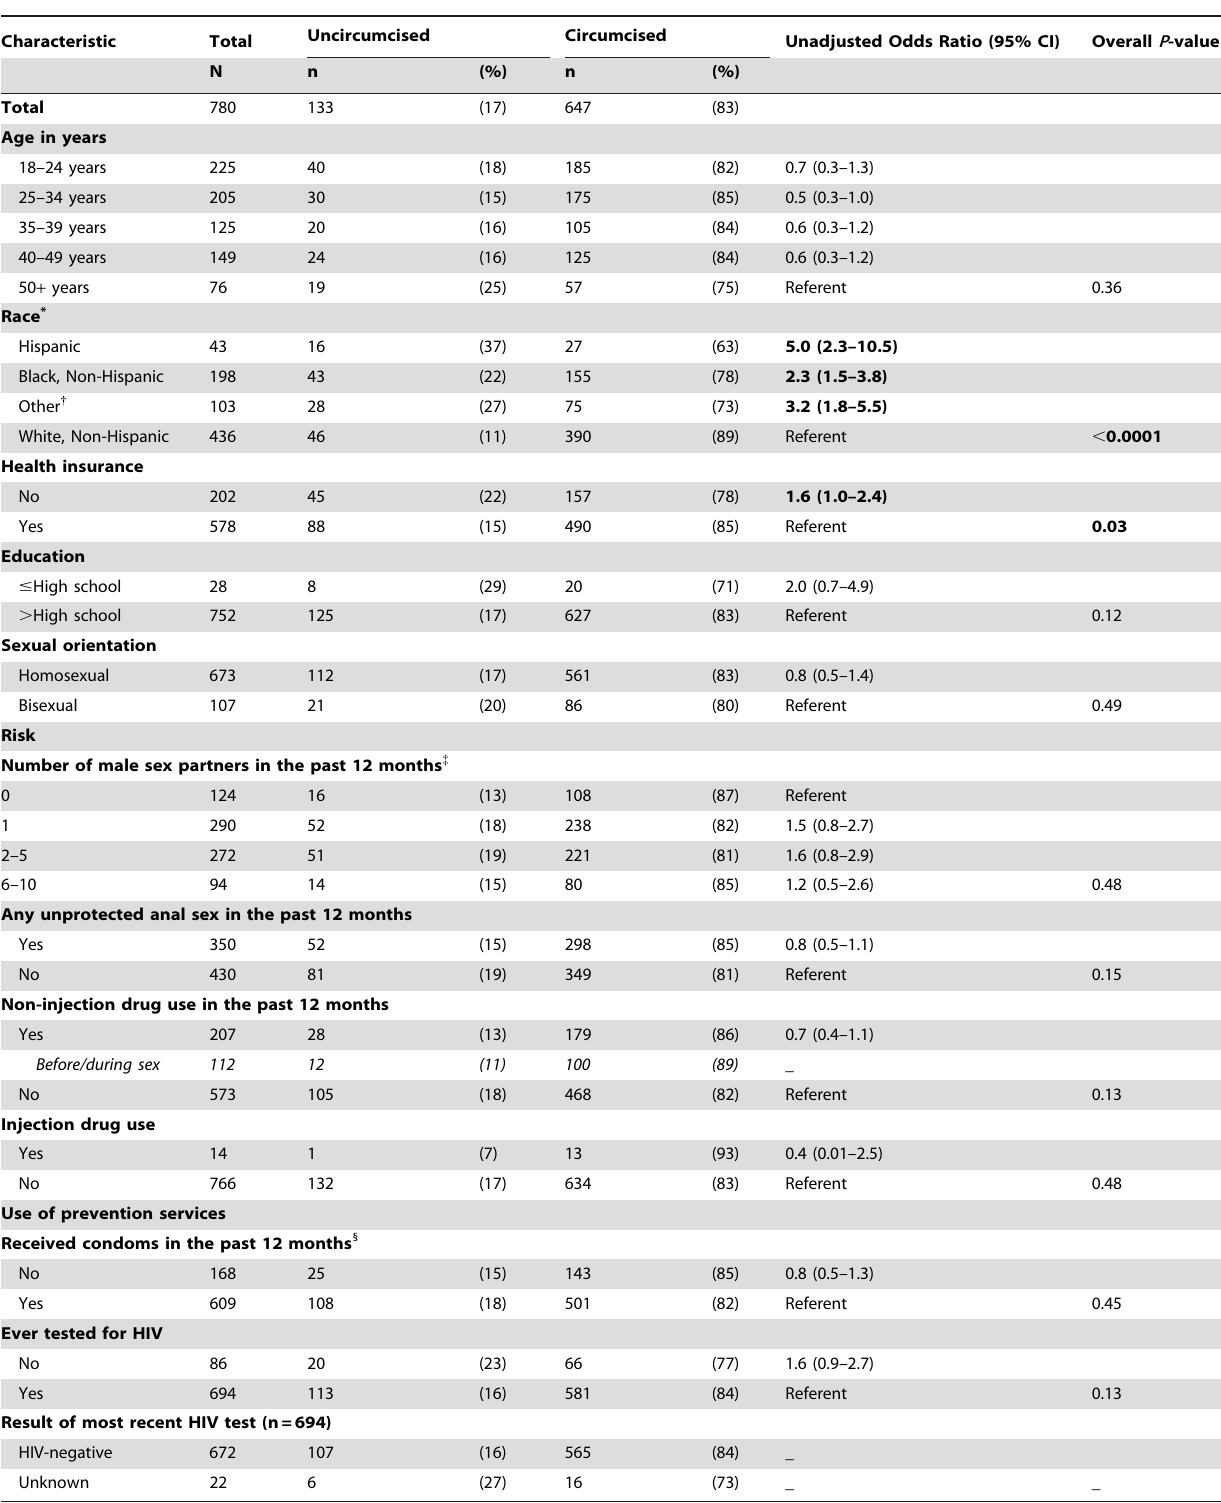
Table 1. Demographic characteristics, behavioral risk factors, HIV testing history, and use of prevention services among 780 men who have sex with men who attended Gay Pride and Minority Gay Pride events in 7 U.S. cities by circumcision status –